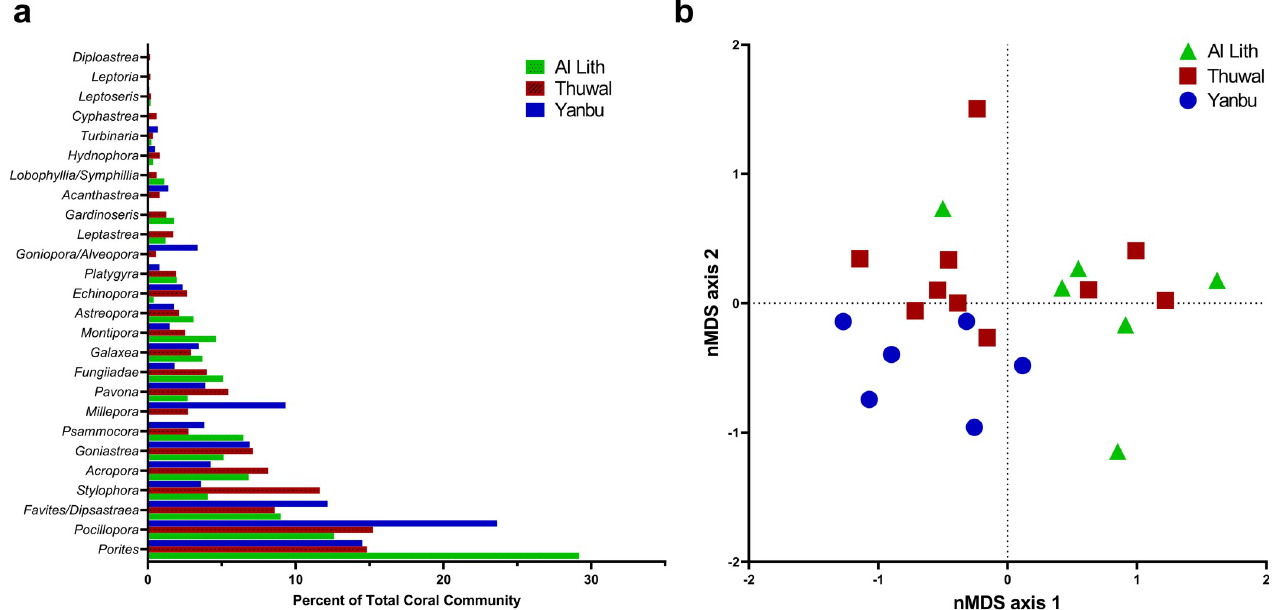
(Table 1). Sites in Yanbu had the highest DHW (avg. 4.9), followed by Al Lith (avg. 4.4)